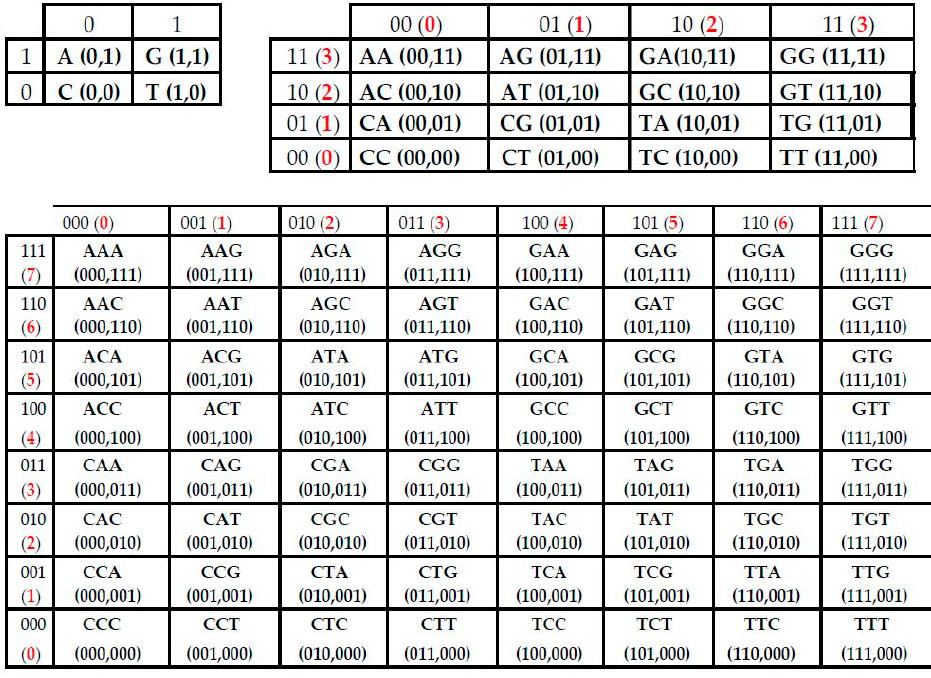
Figure 1. The first members of the Kronecker family of symbolic genomatrices [A G; C T] ( N ) for n = 1, 2, 3. Inside each genomatrix [A G; C T] ( N ) , each row and each column has its individual binary numeration due to genetic sub-alphabets (see explanation in text below). Correspondingly each N -plet, which is located on a row-column crossing, has two digital binary coordinates in such matrix. The decimal equivalents of these binary numbers are shown in red.